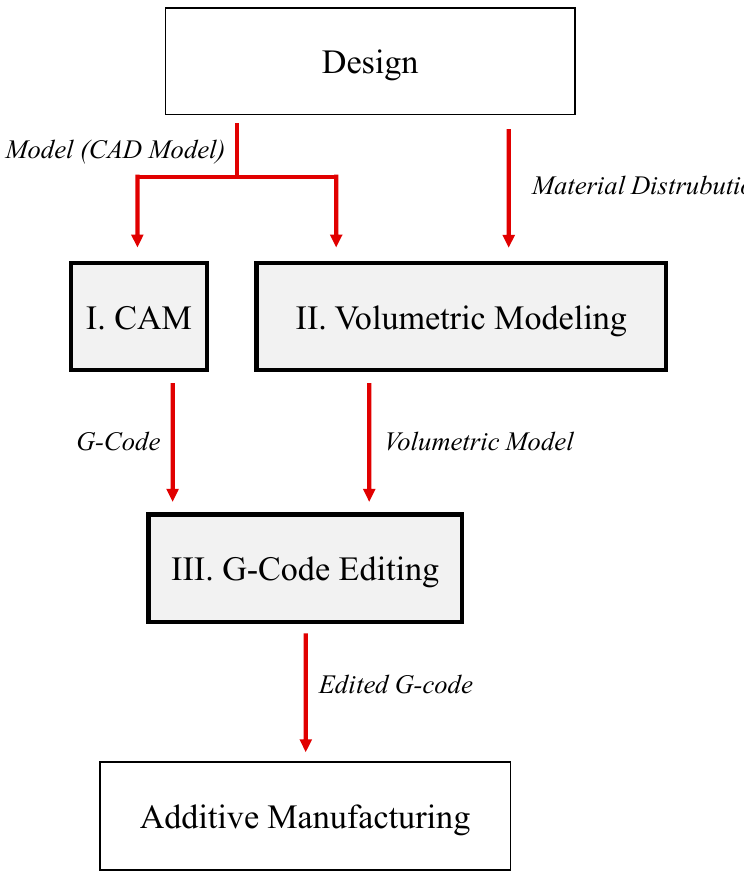
Figure 1. Overview of the proposed method.